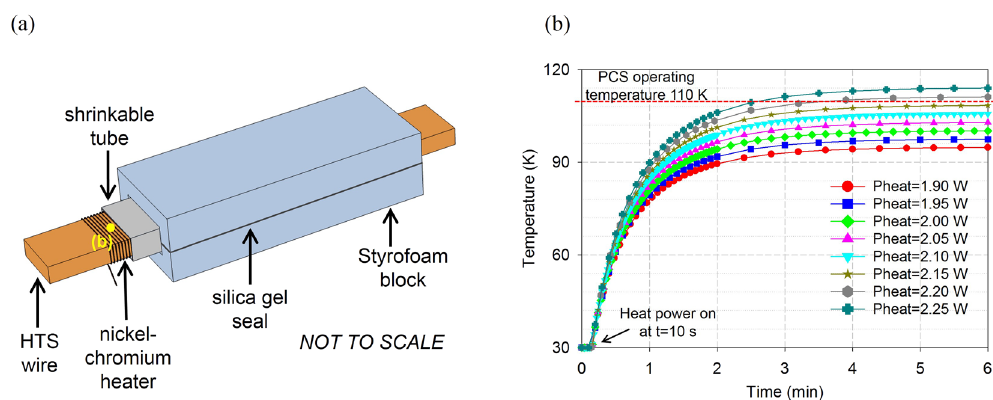
Figure 7. The heat-triggered PCS is converted from a 70 mm section of the HTS wire. ( a ) Structural drawing of the PCS. Note that the nickel-chromium heater and shrinkable tube are actually enclosed in the Styrofoam heat “trap”. The temperature point on the PCS shows that ( b ) the PCS is opened within 5 min by 2.20 W heat